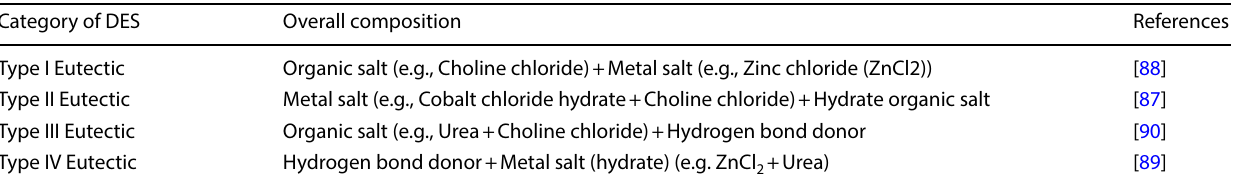
Table 7 Classification of DESs Category of DES Overall composition Type I